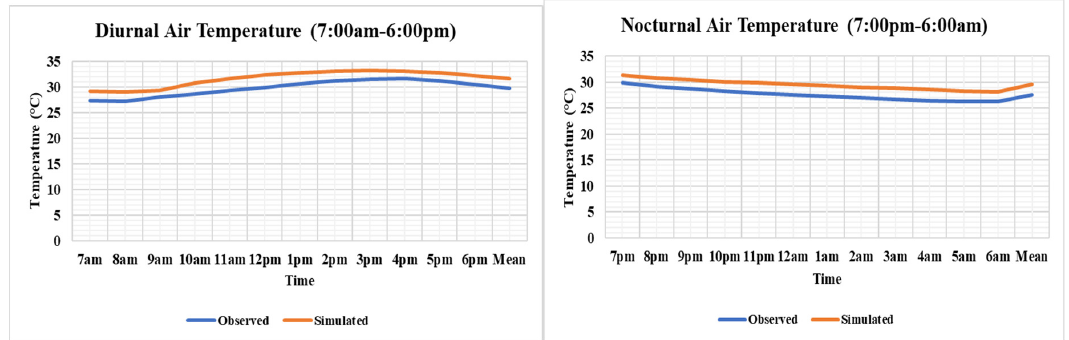
Figure 5. Measured and simulated results of diurnal and nocturnal air temperatures at SM.